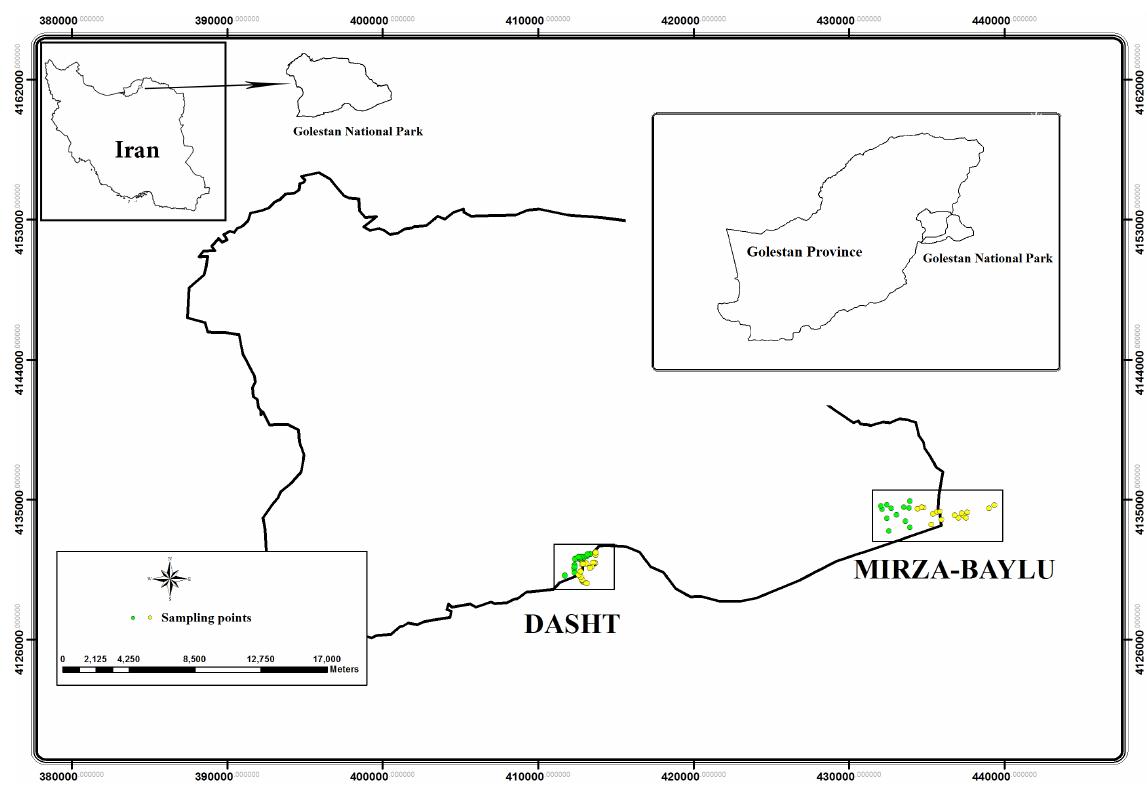
Figure 1. Map of study area in Golestan National Park, Golestan Province, Iran. Dasht is located in the southern part of the park and Mirza Baylu is located in the eastern part of the park. The points are sampling